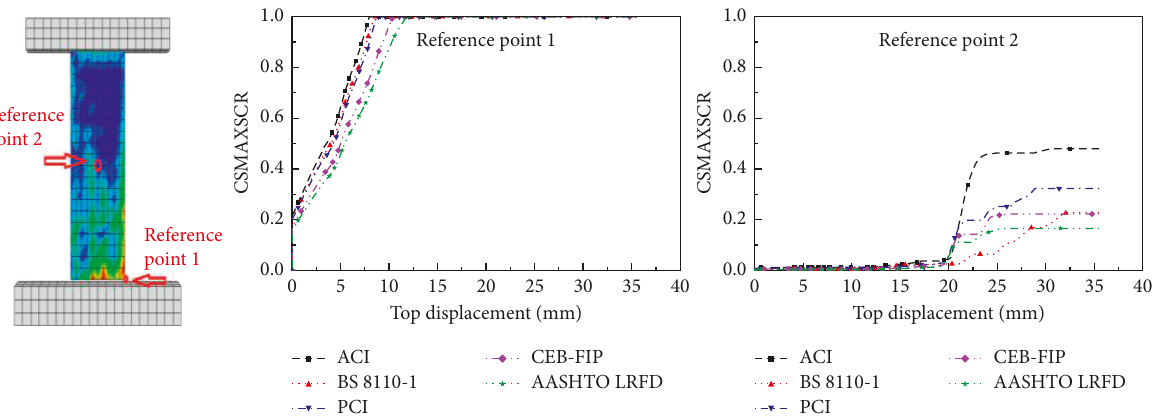
Figure 27: CSMAXSCR-top displacement curves of W2 under 0.5 axial compression